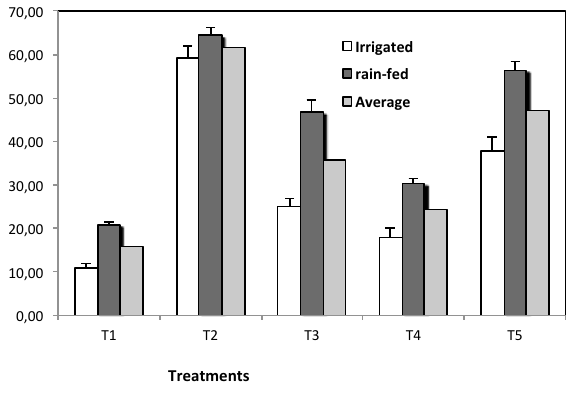
Figure 4. Mean rice grain yields from single and mixed inoculations of Ditylenchus angustus and Aphelenchoides beseyi . Treatment (T), A. besseyi : D. angustus, , T1 = 100:0; T2 = 0:100; T3 = 50:50; T4 = 75:25; T5 = 25:75. Vertical bars indicate standard